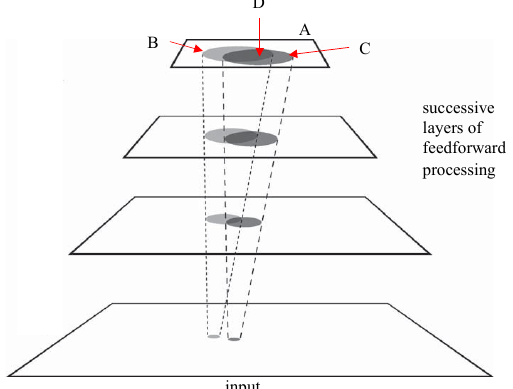
Figure 4. Crosstalk example. The figure illustrates the spatial region within in which the overlap makes an impact (region D in the top layer but this region evolves layer by layer from the input forward). The result is that, for two stimuli in the input, three regions with potentially different interpretations appear not only at the top layer (where they are labelled as B, C, and D and red arrows identify them), but in each layer. In other words, the input signal is rendered ambiguous. Attentional processes that suppress the interference in a top-down traversal, subsequent to the initial feedforward traversal, ameliorate this problem [23]. The spacing of stimuli clearly matters; the number of input stimuli also matters. (Adapted from [31], where the algorithm for how to realize such a top-down suppression is given).